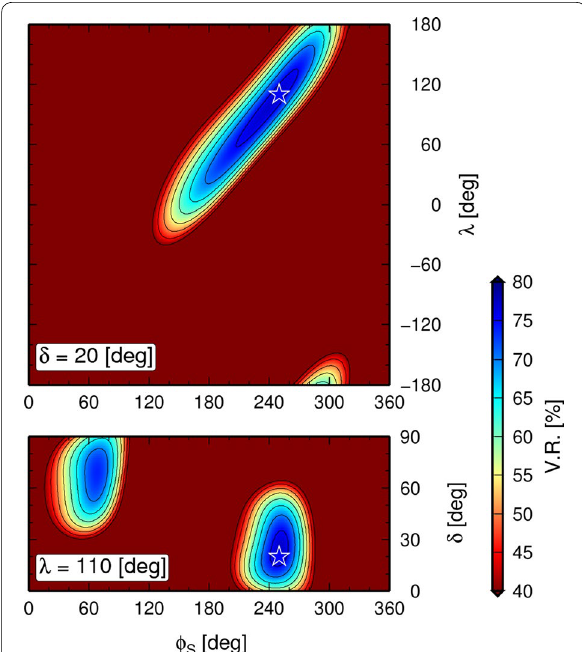
Fig. 9 Distribution of the variance reduction (V.R.) in the strike-rake ( φ S – λ ) and strike-dip ( φ S – δ ) planes. Variance reductions were evalu- ated by using observed and synthetic F-net displacement waveforms for periods of 30–100 s. Synthetic waveforms were calculated for various focal mechanisms with a fixed centroid depth and seismic moment. White stars indicate the best-fit double-couple model of our MT results for the 2016 SE offshore Mie